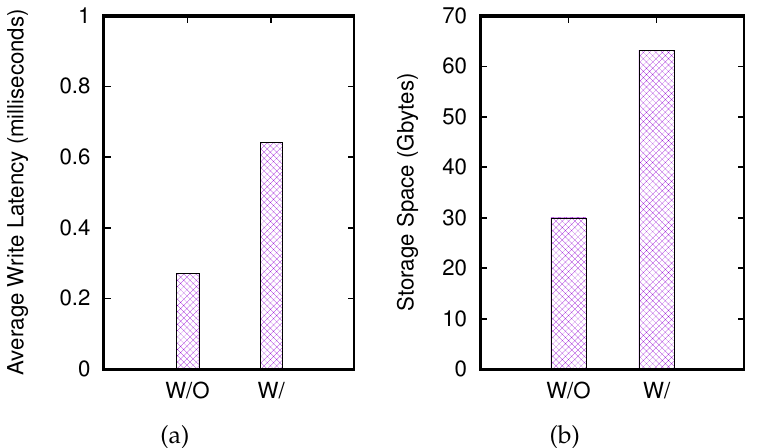
Figure 6. Overheads, where ( a ) is the delay for write operations, and ( b ) the storage space